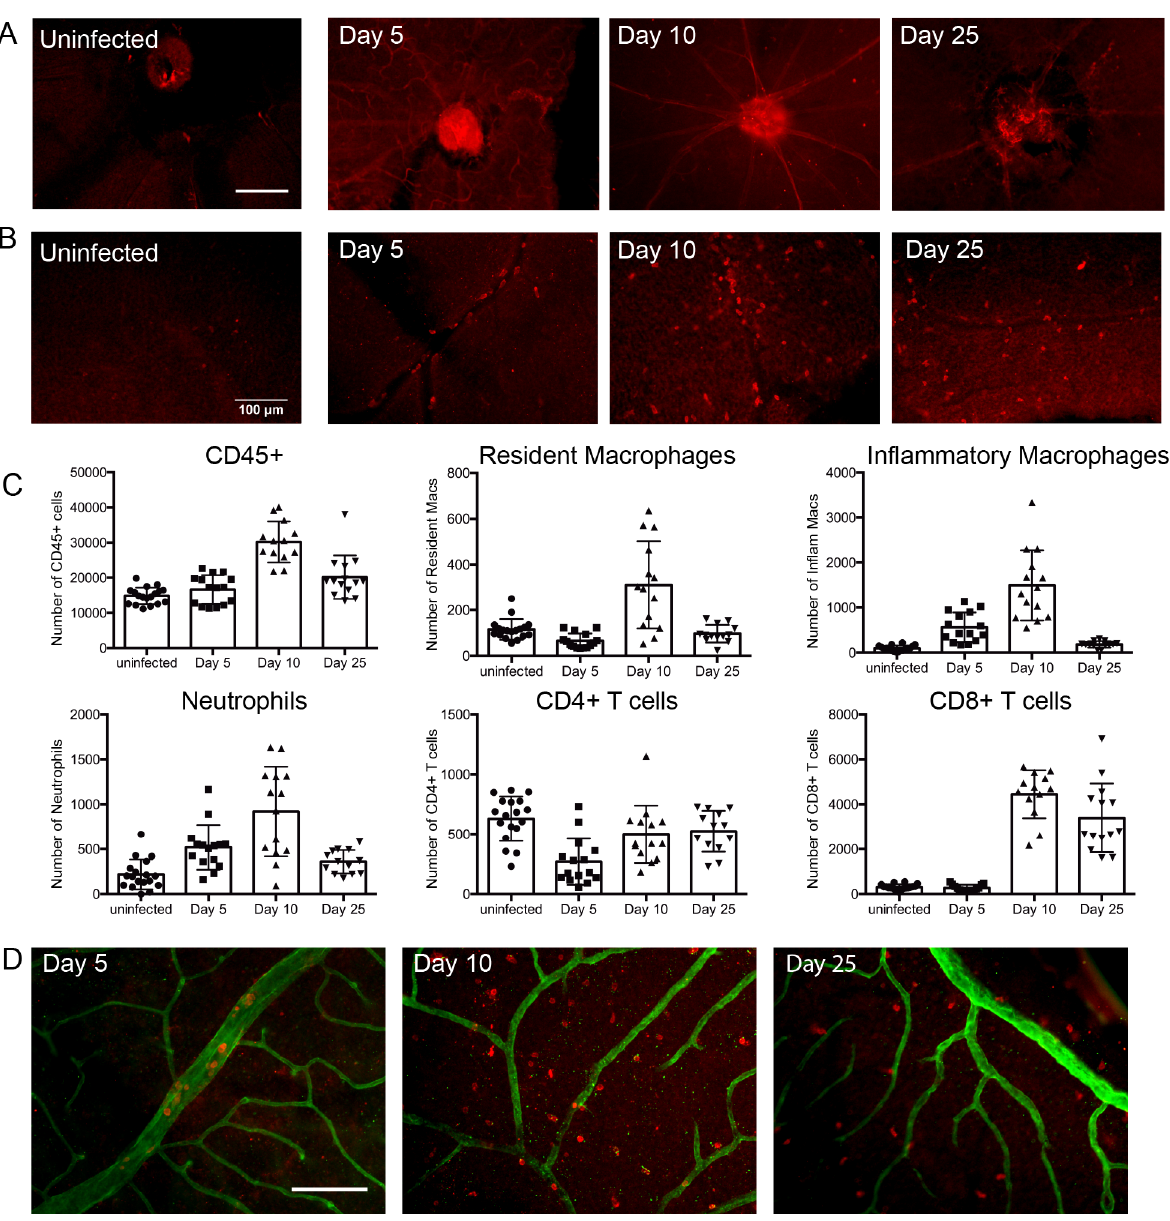
Fig 7. Leukocytes and lymphocytes, including T cells, infiltrate and accumulate in the retina after systemic MCMV infection. Retinal sections were stained with (A) anti-MHC-II or (B) anti-CD45 antibodies. (C) Mice were infected with MCMV and at the indicated times pi the retina isolated. Single cell preparations from individual retina samples were stained with lineage specific antibodies and analysed by flow cytometry. The percentages of cells in specific populations are graphed as mean ± SEM where n (cid:21) 10 mice for each time point from 3 independent experiments. (D) Retinal whole-mounts at the indicated times pi were stained with collagen IV (green) anti-CD45 (red) antibodies. Scale bars: 100 μm.